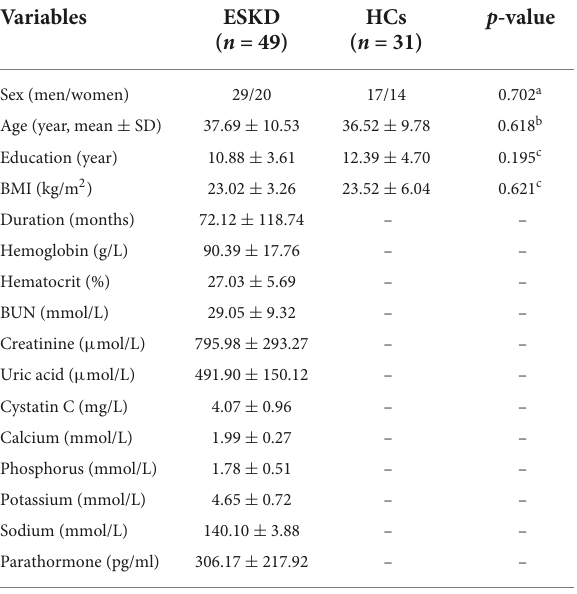
TABLE 1 Demographic information and clinical characteristics in patients with ESKD and HCs.